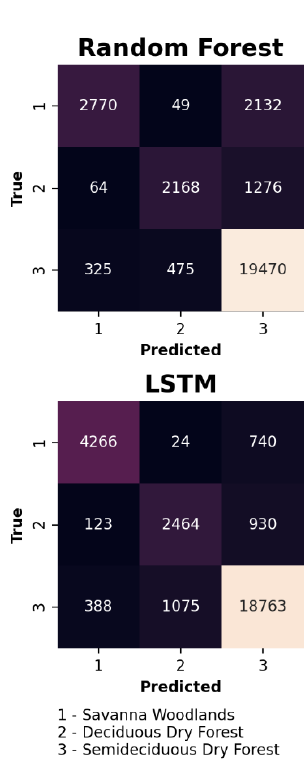
Figure 4 . Confusion matrices.